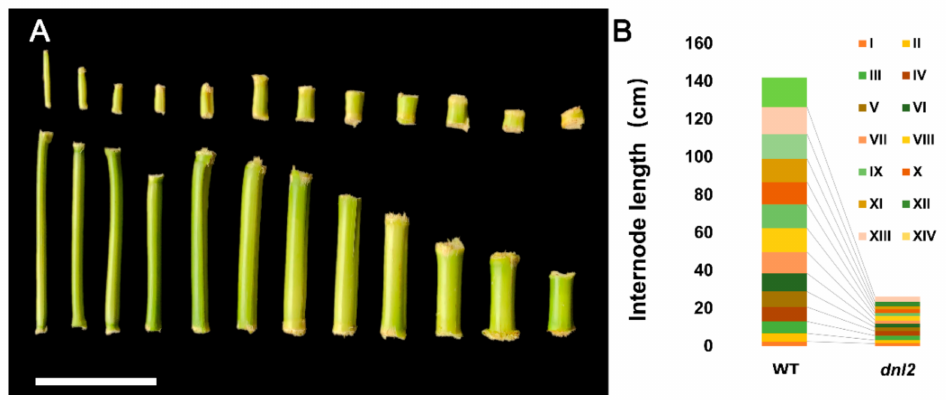
Figure 2. Comparison of the length of the internodes of dnl2 and the wild-type. ( A ) Internodes of dnl2 and the wild-type, bar = 10 cm; ( B ) Comparison of internodes length between dnl2 and the